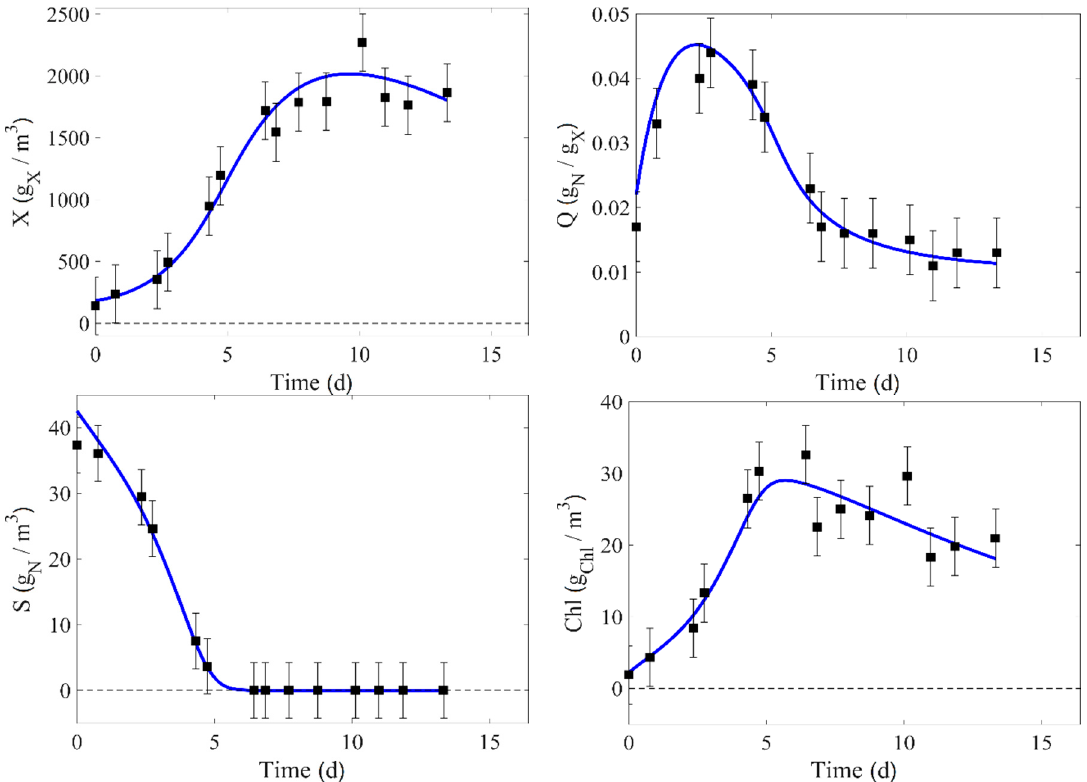
Figure 2. Experimental data (with 95% error bars) and model prediction for run 4.